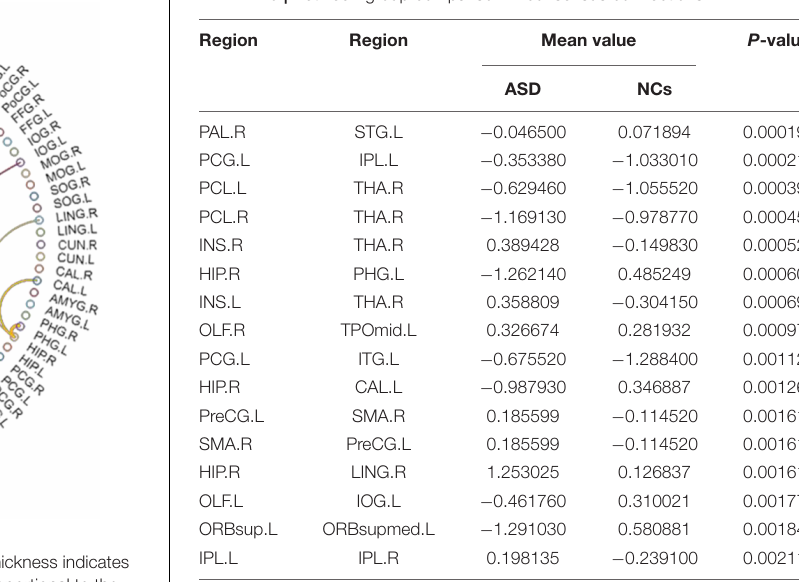
TABLE 10 | Between-group comparison in consensus connections.